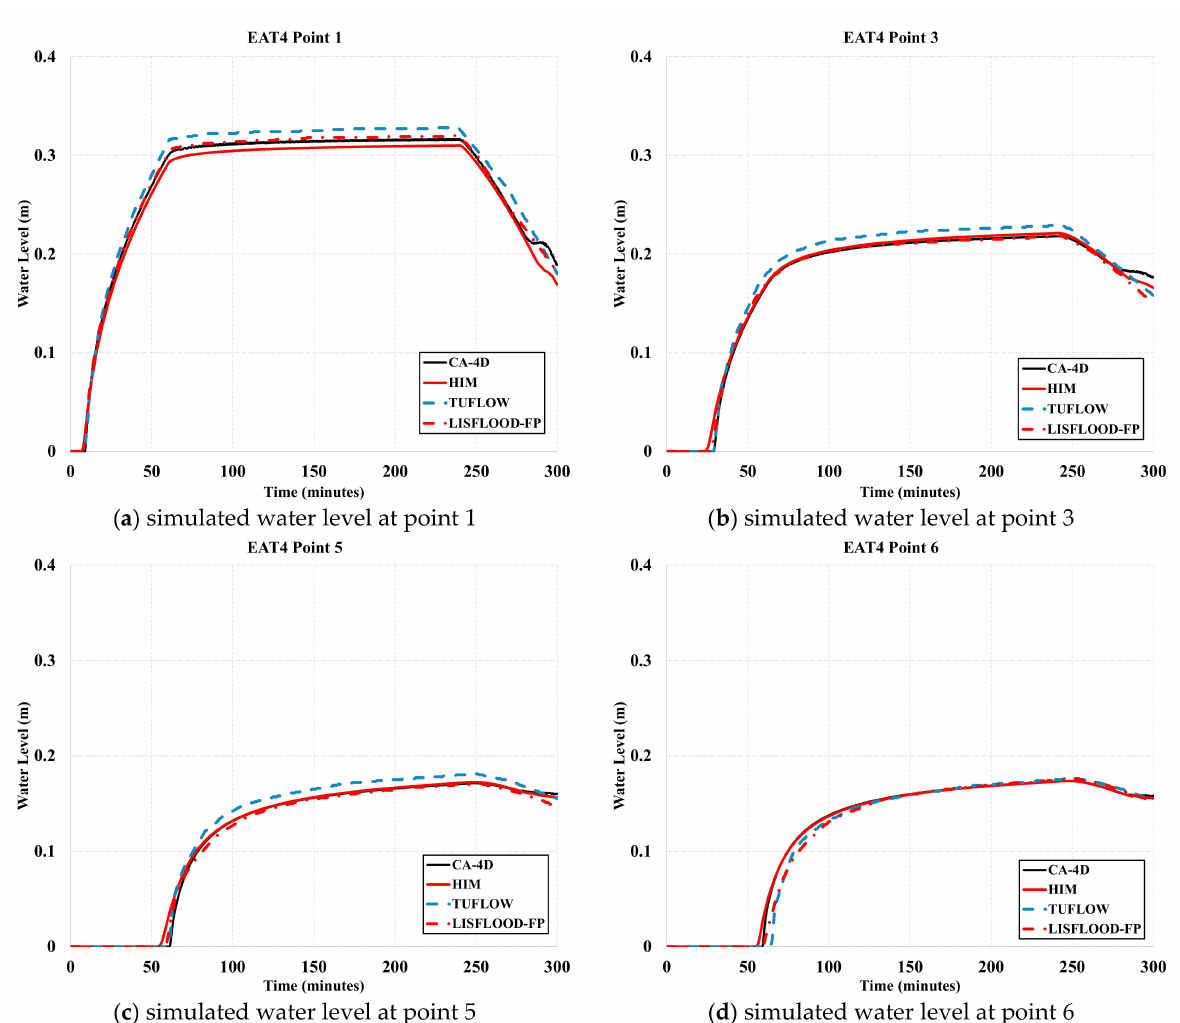
Figure 9. Temporal variation in water level for EAT4 at points 1, 3, 5, and 6; comparison among the CA-4D, HIM, TUFLOW, and LISFLOOD-FP models; ( a ) simulated water level at point 1; ( b ) simulated water level at point 3; ( c ) simulated water level at point 5; ( d ) simulated water level at point